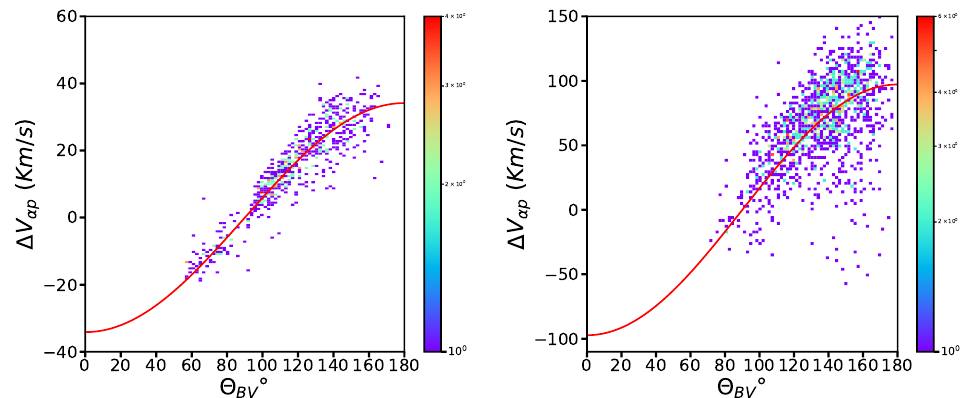
Figure 7. 2D histogram plot of alpha proton drift speed as a function of θ BV ; the red curve is fitted √ r A for the fast wind interval of 10 June 2015 ( left ) using the equation A ∗ V A ∗ cos θ BV , where A ∼ from WIND at 1 au and the fast wind interval of 17 April 1976 ( right ) from HELIOS 2 ∼ 0.3 au. The color bar represents the number of